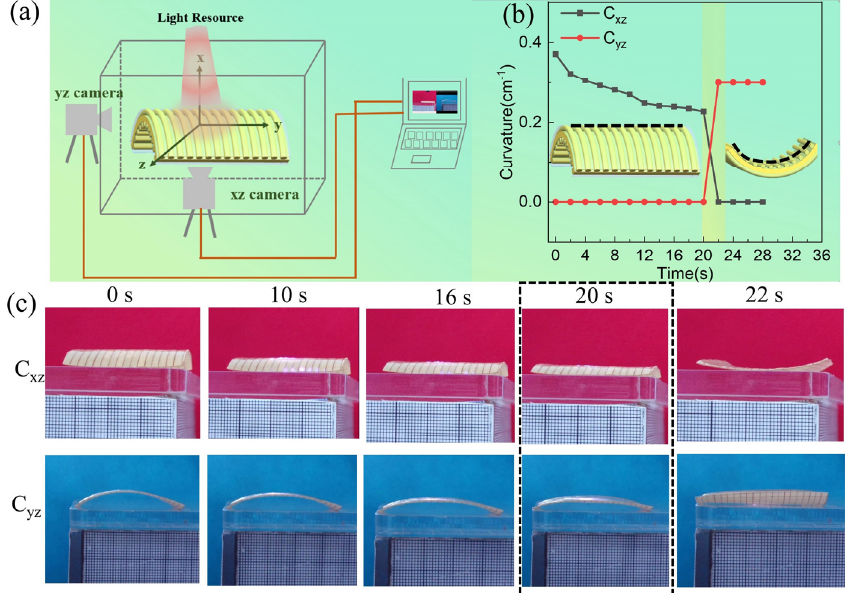
Figure 7. ( a ) Schematic of the experimental device established for testing the light response of the bi ‐ stable composite antenna. ( b ) The relationship between the bending of the bi ‐ stable composite antenna with the light ‐ actuated time. ( c ) Photograph of the bi ‐ stable composite antenna changing with light ‐ actuated